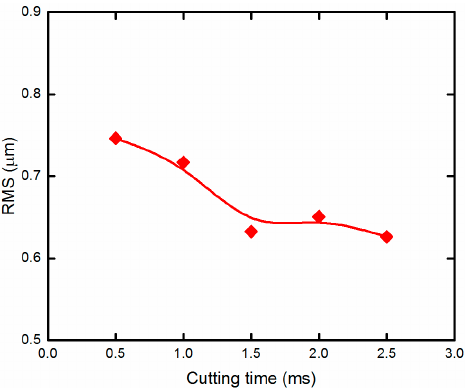
Figure 12. Form error of micro lenses machined at different cutting time of every discrete point.